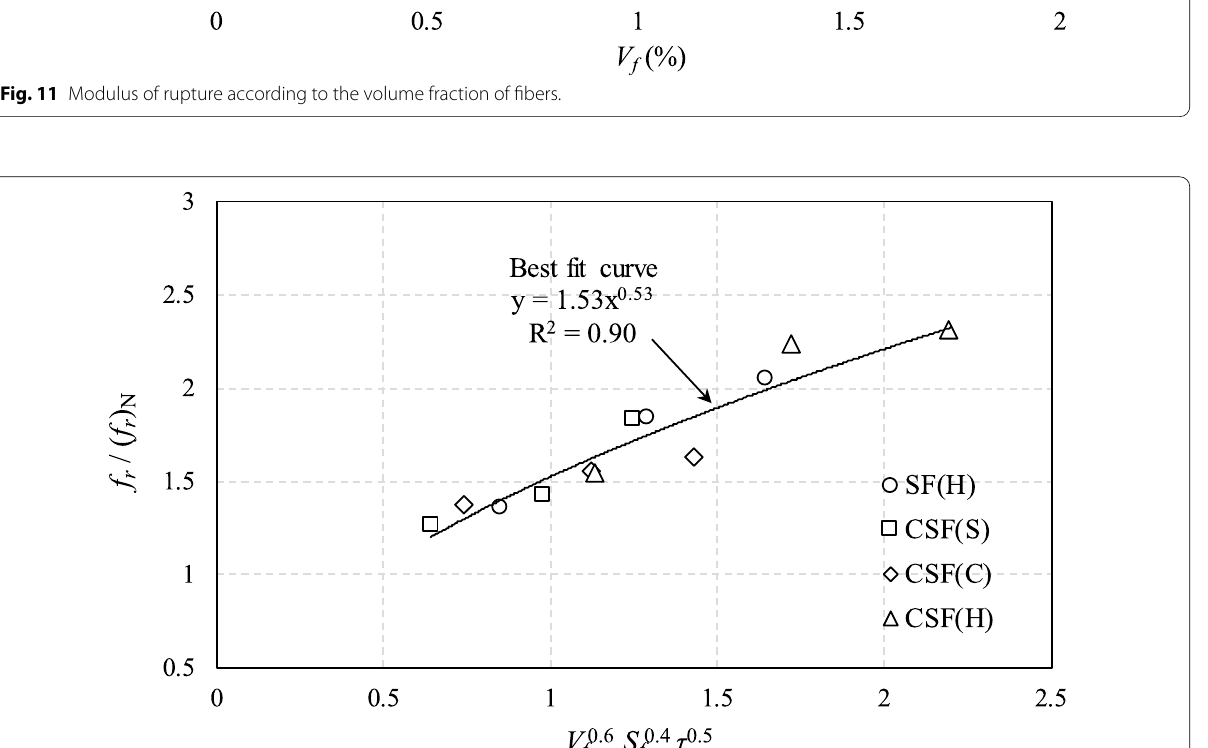
Fig. 12 Regression analysis for normalized modulus of rupture of